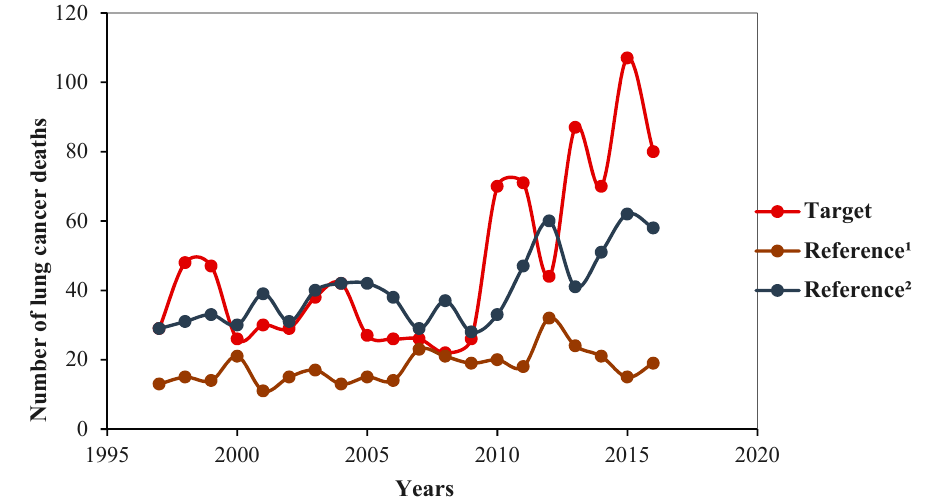
Figure 13. Comparison between lung cancer deaths in both radon exposed and non-exposed areas.